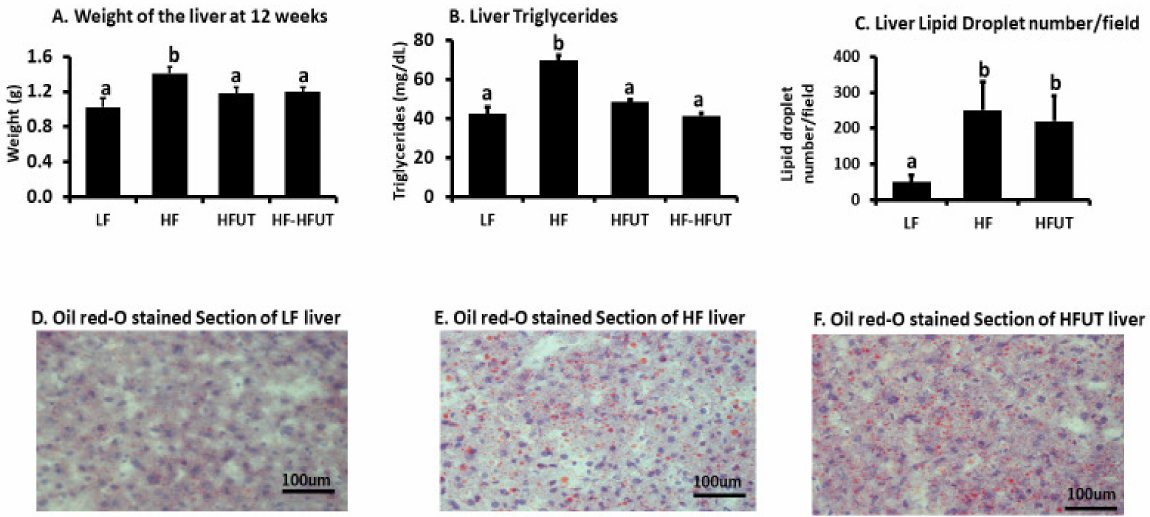
Figure 4. Supplementation with UT vegetable lowers liver weight and liver triglycerides but not liver lipid droplet number. ( A ) The weight of the liver was higher in HF compared to LF fed group ( p < 0.05; n = 9). Supplementation of the HF diet with UT vegetable from beginning of the study or after 6 weeks of HF feeding lowered liver weight to levels similar to that of the low fat (LF) ( p < 0.05; n = 8–9). ( B ) Liver triglycerides were higher in HF compared to LF fed group ( p < 0.05; n = 9). Supplementation of the HF diet with UT vegetable from beginning of the study or after 6 weeks of HF feeding lowered liver triglycerides to levels similar to those of the LF group ( p < 0.05; n = 8–9). ( C – F ) Oil red O (ORO) stained liver slides from HF fed mice showed highly increased lipid droplets compared to the LF group. letters indicate a significant di ff erence among treatments at p < 0.05.